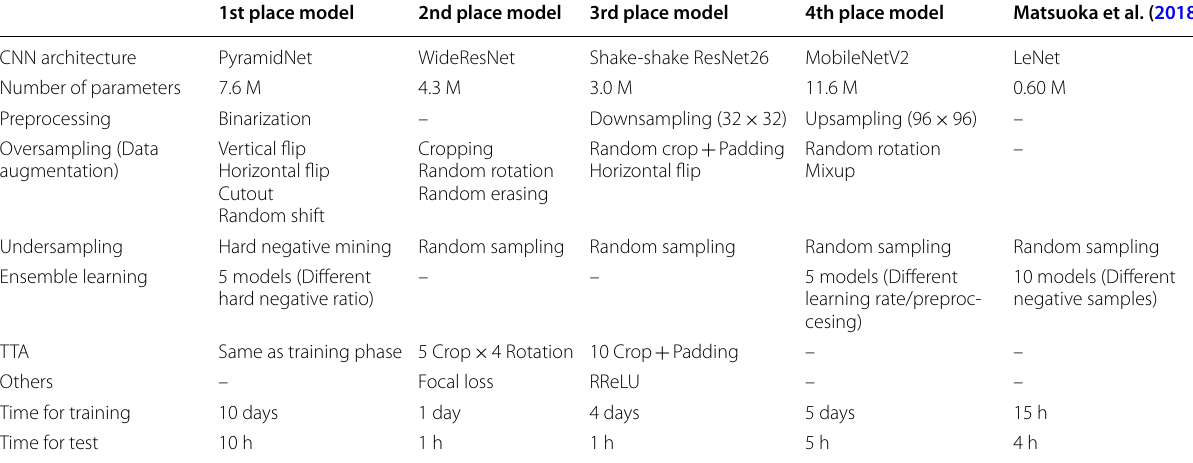
Table 1 Typical methods and elapsed times for each of the top models in the